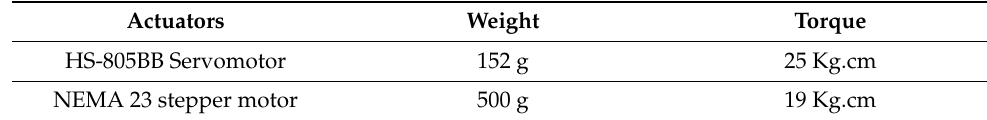
Figure 2. Three-dimensional design of the robot: (1) Inner plate; (2) Forearm outer plate; (3) Arm outer plate; (4) Giant scale servo motor-HS-805BB; (5) Nema stepper motor; (6) Screw-nut system; (7) Servo-motor HS-755HB. Table 1. The robot actuators.